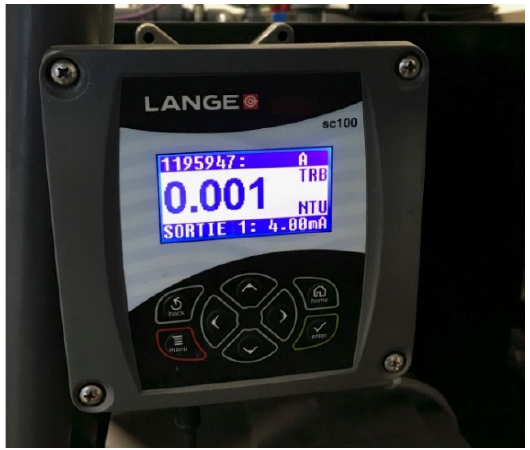
Figure 2. Typical turbidity reading during the filtration period.